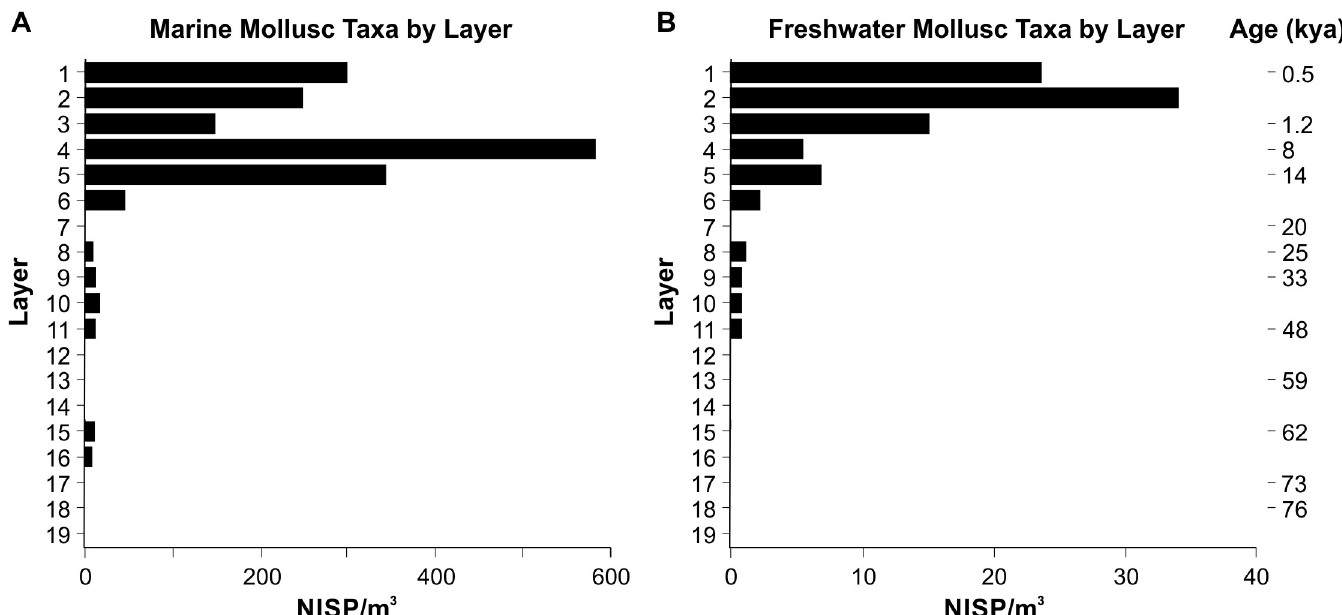
Fig 9. Distribution (NISP/m 3 ) through the PYS sequence by Layer of marine (A) and freshwater (B) mollusc taxa. Note differences in horizontal scales.